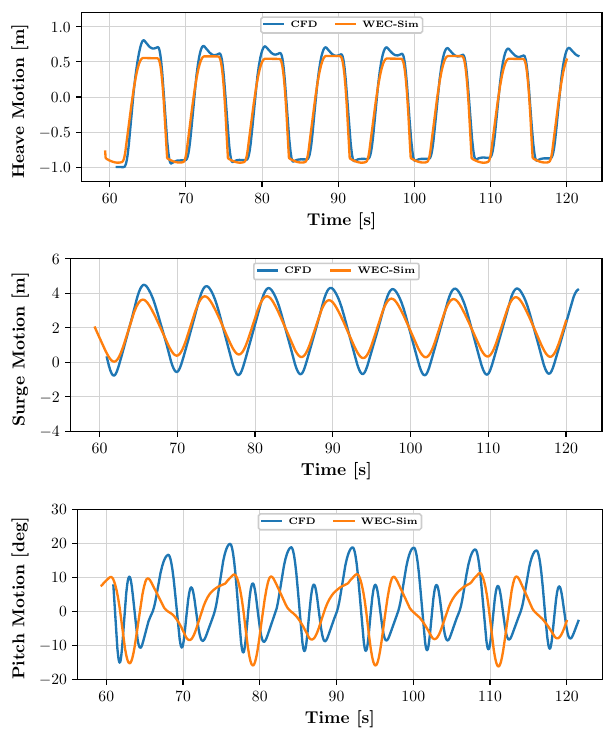
Fig. 10. The WEC is restricted in heave, surge, and pitch motion (3 DoF case). The upper plot represents the time series of heave response, the middle plot the surge response, and the lower plot the pitch response.